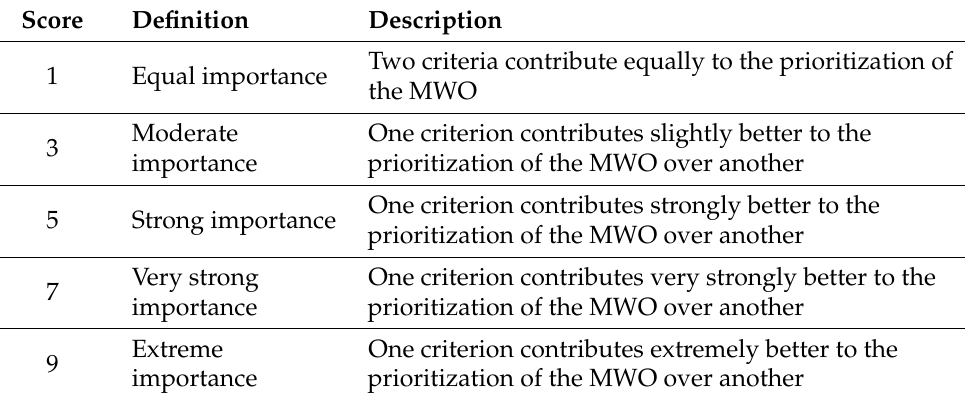
Table 6. Scale for pairwise comparison of criteria.